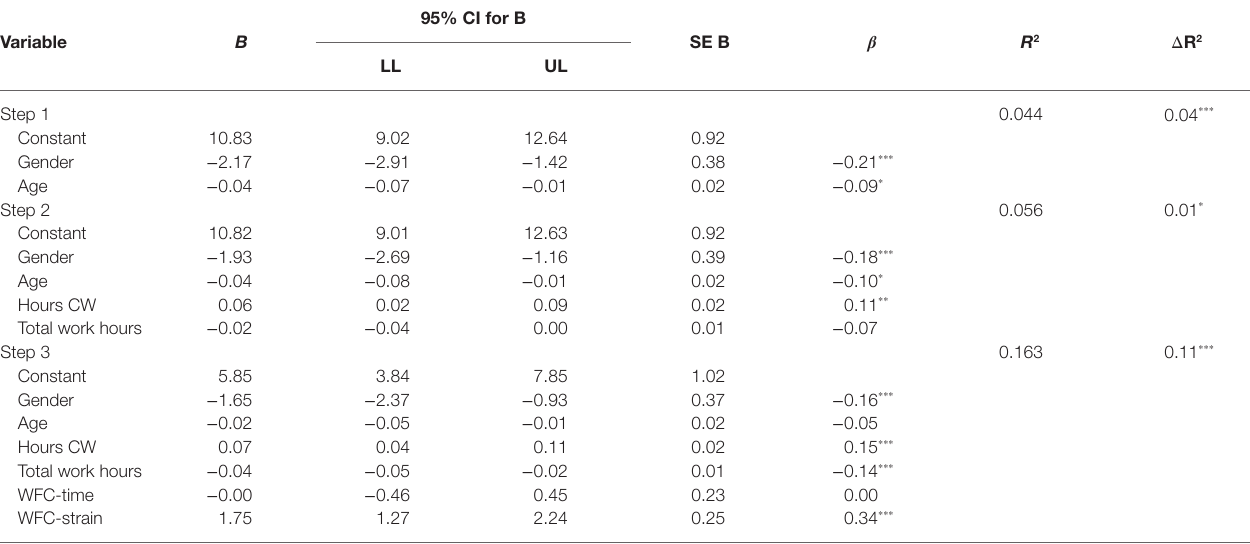
TABLE 4 | Hierarchical regression results for somatic symptoms.